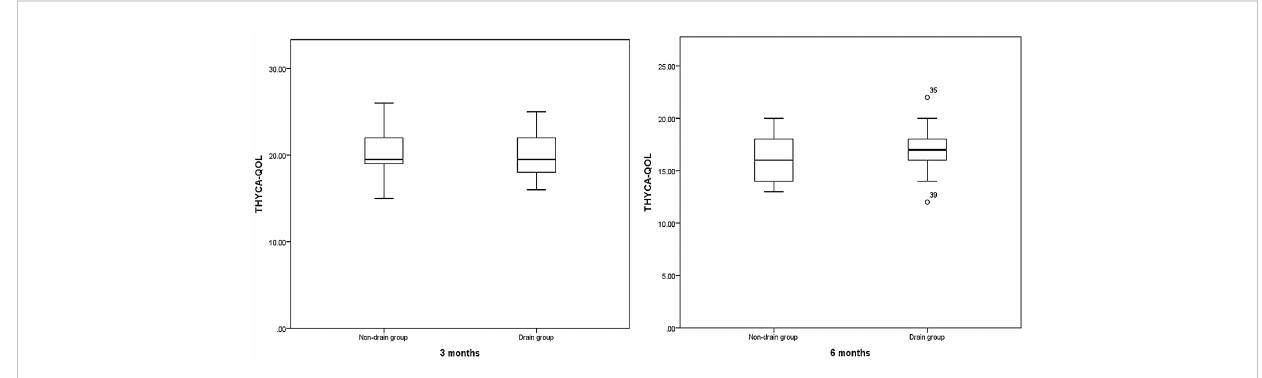
FIGURE 3 Comparison of THYCA-QOL between Non-drain group and Drain group. P= 0.781,